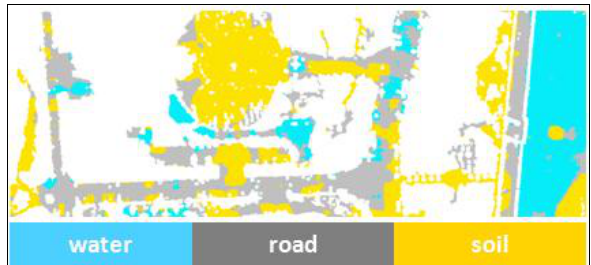
Figure 17. The classification result of the mixture